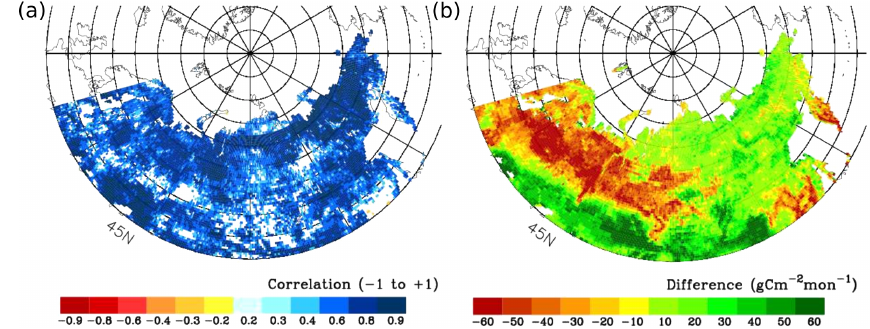
Figure 3. Spatially explicit validation of GPPsat using upscaled FLUXNET observations. Panel (a) is the correlation map and displays the statistically significant (95% level) correlations between the two sets of values of annual GPP for the period of 1982–2010. Panel (b) is the difference between the 29-year mean of GPPsat and upscaled FLUXNET database, with negative values demonstrating an underestimation of GPPsat and vice